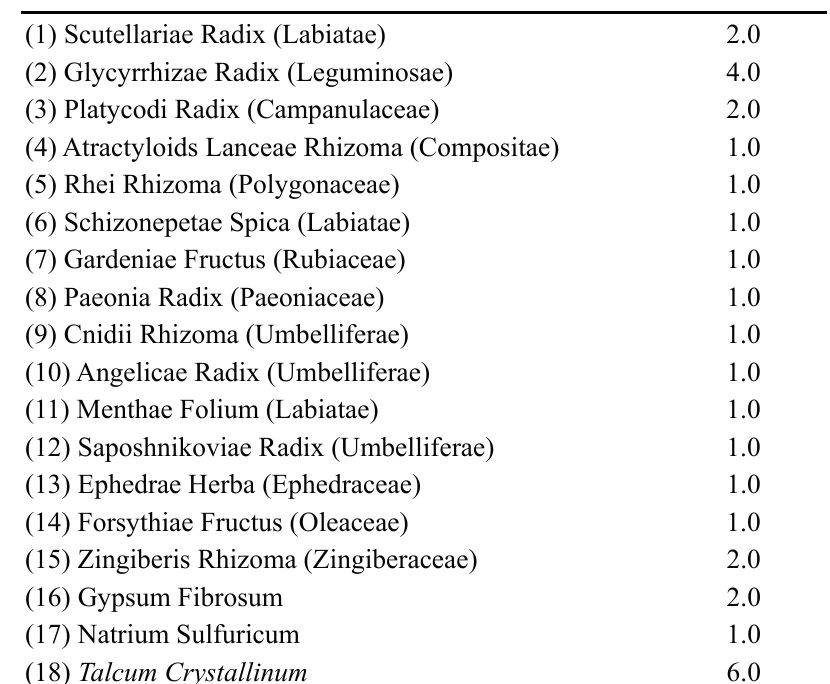
Table 1. Components of Bofu-tsusho-san (BO). 9 g extract of the above raw materials a . See Materials and Methods for